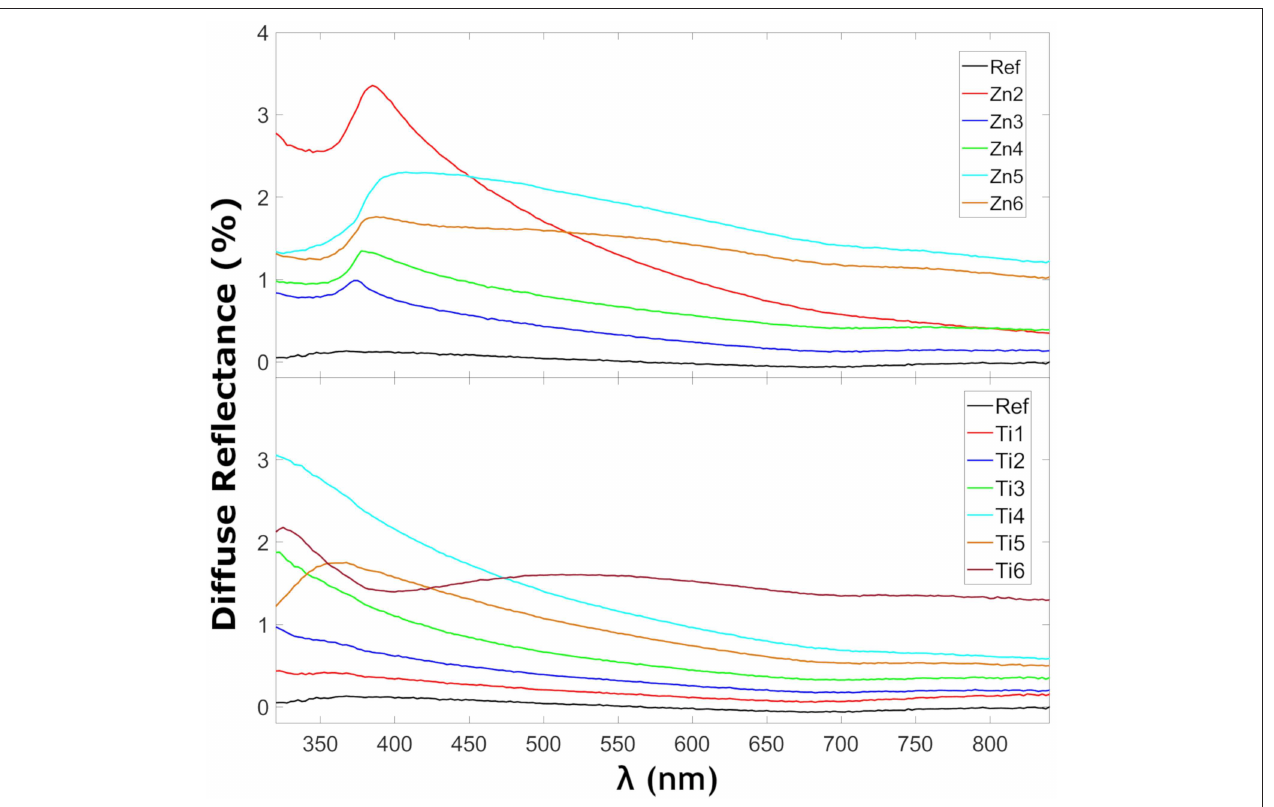
FIGURE 5 | Diffuse reflectance of thin film-coated glass samples.